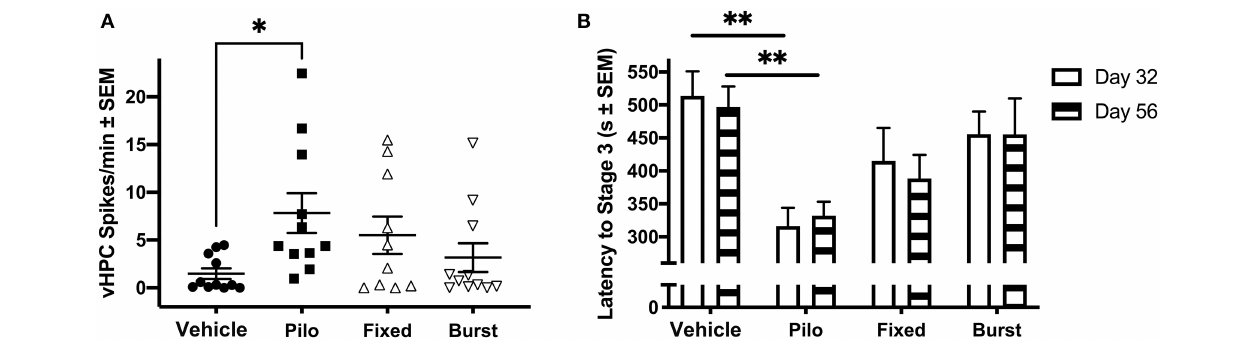
FIGURE 3 | Ictal activity in epileptic animals. (A) During the novel object recognition task, there was a significant difference in spike rate when comparing Pilo animals with Vehicle. (B) On PPD32 and 56, Pilo animals demonstrated significantly reduced stage 3 seizure threshold as compared to Vehicle animals. Both stimulation groups had similar seizure thresholds to the Vehicle group. * p < 0.05, ** p < 0.01.